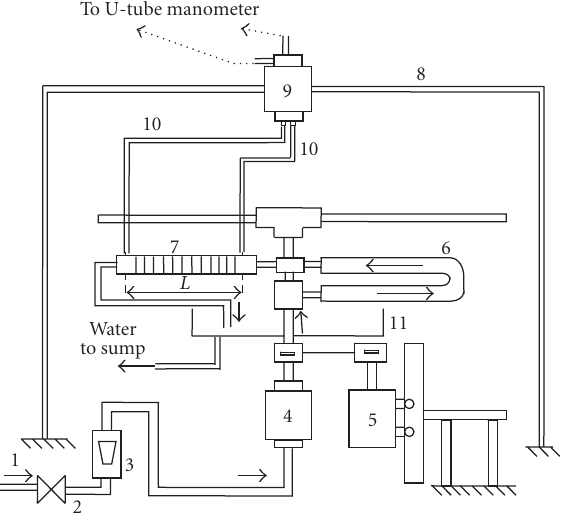
Figure 1: Experimental setup. (1) Water pumped from the sump. (2) Control valve. (3) Rotameter. (4) Bottom rotor seal. (5) D.C. Motor. (6) Developing region. (7) Test section. (8) Support frame. (9) Top rotor seal. (10) Flexible tubes connected to pressure taps. (11) Collection tank.